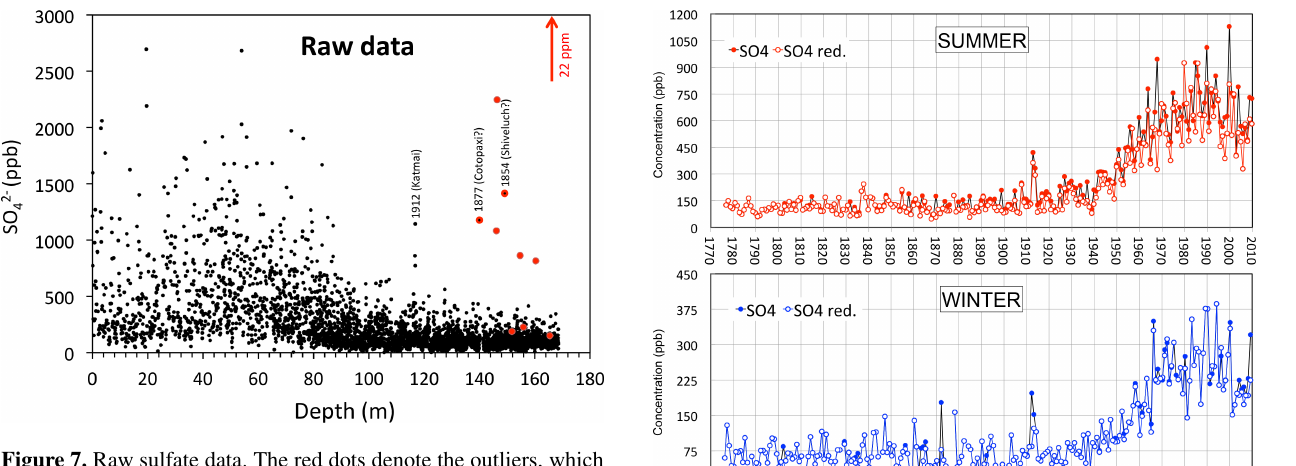
Figure 7. Raw sulfate data. The red dots denote the outliers, which were removed prior to calculation of the half-year summer and win- ter means. We also indicate samples possibly impacted by the vol- canic eruptions of Cotopaxi and Shiveluch (see text).